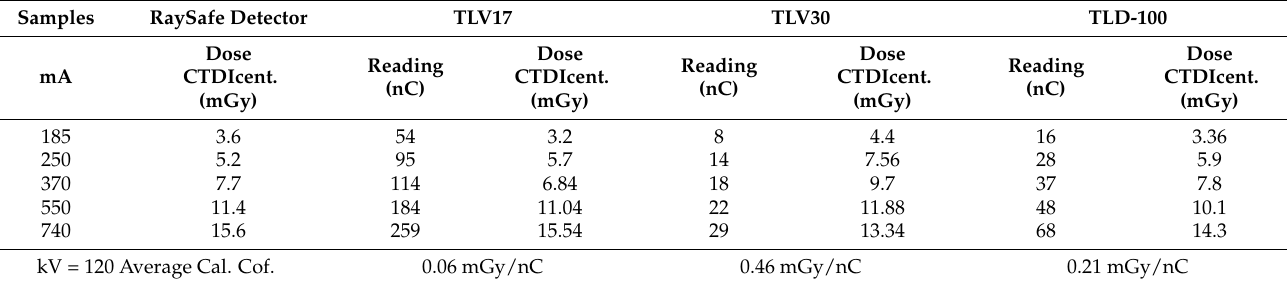
Table 5. TLV17, TLV30 and TLD-100 CT radiation dose results.